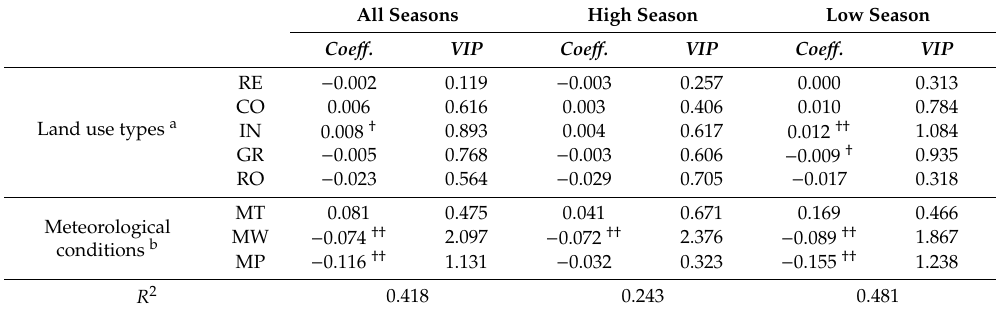
Table 4. Estimation of PM 2.5 levels based on land use classification I using PLS regression